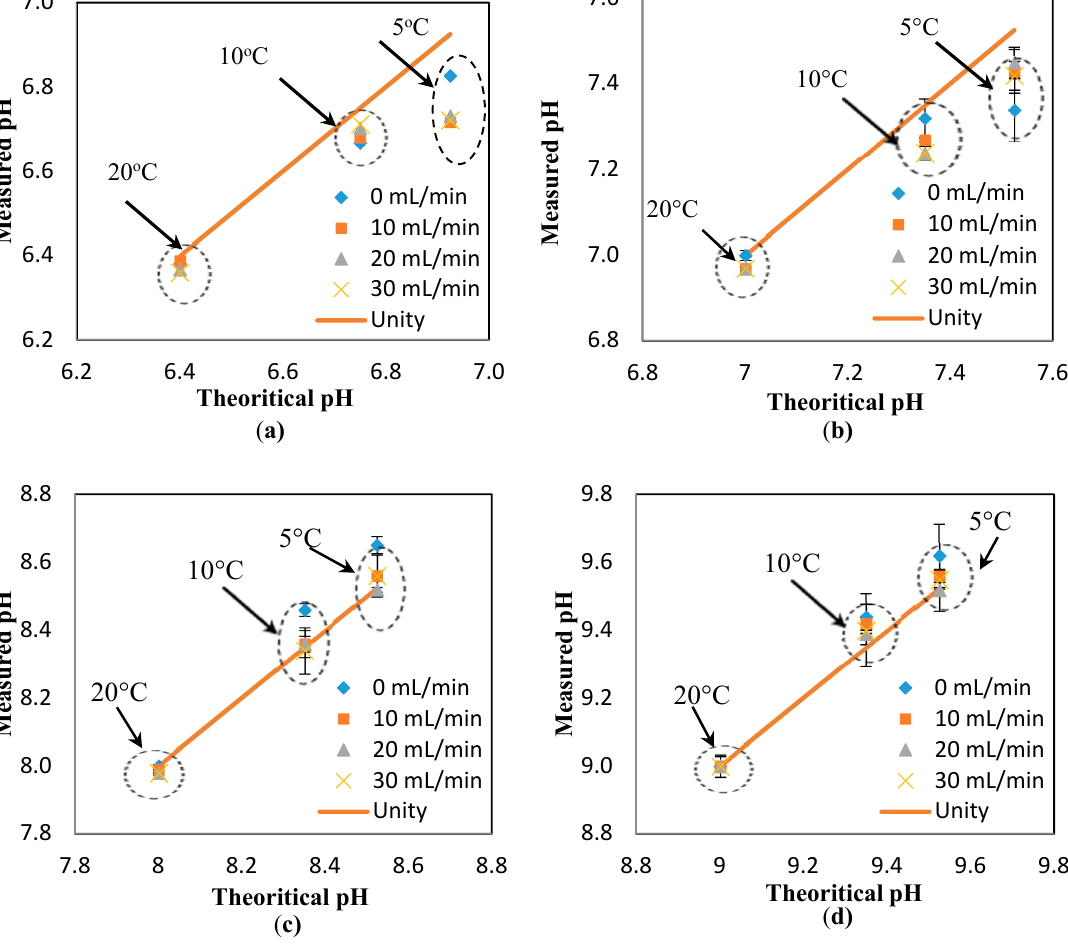
Figure 3. Effect of the flowrate on the response of the sensor measured at different temperatures and dynamic condition. The curves illustrate the deviation from the theoretical pH values (using the “unity line”) for different pH ranges of ( a ) 6.4; ( b ) 7; ( c ) 8; and ( d ) 9.